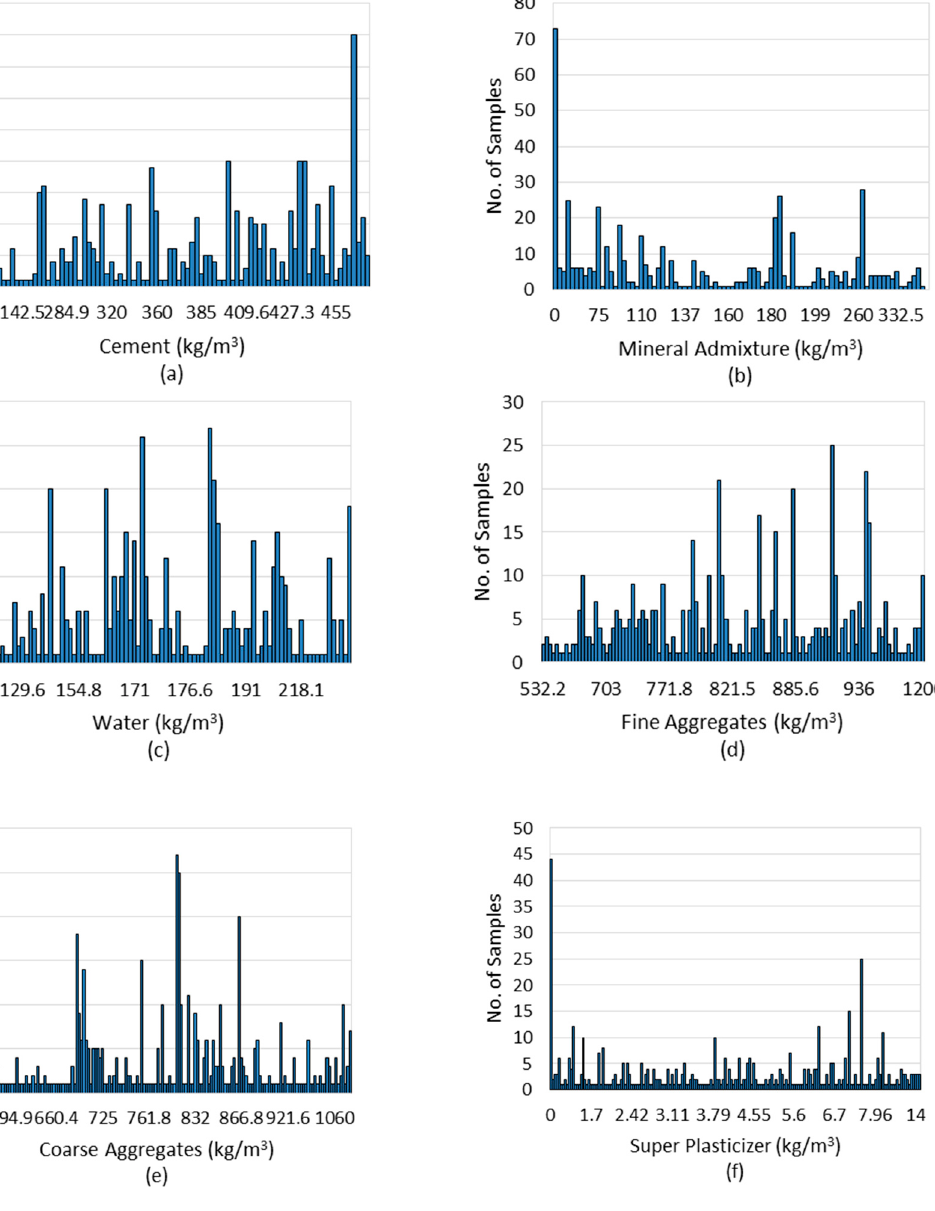
Figure 3. Frequency analysis (histogram) of input parameters: ( a ) Cement; ( b ) Mineral Admixture; ( c ) Water; ( d ) Fine Aggregates; ( e ) Coarse Aggregates; ( f ) Superplasticizer.